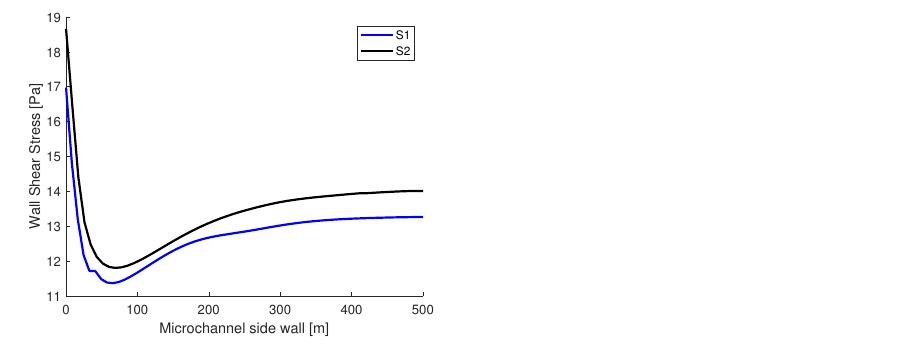
Figure 12. Wall shear stress distribution on the sidewall at h = 25 µ m at the intersection with the middle plane.